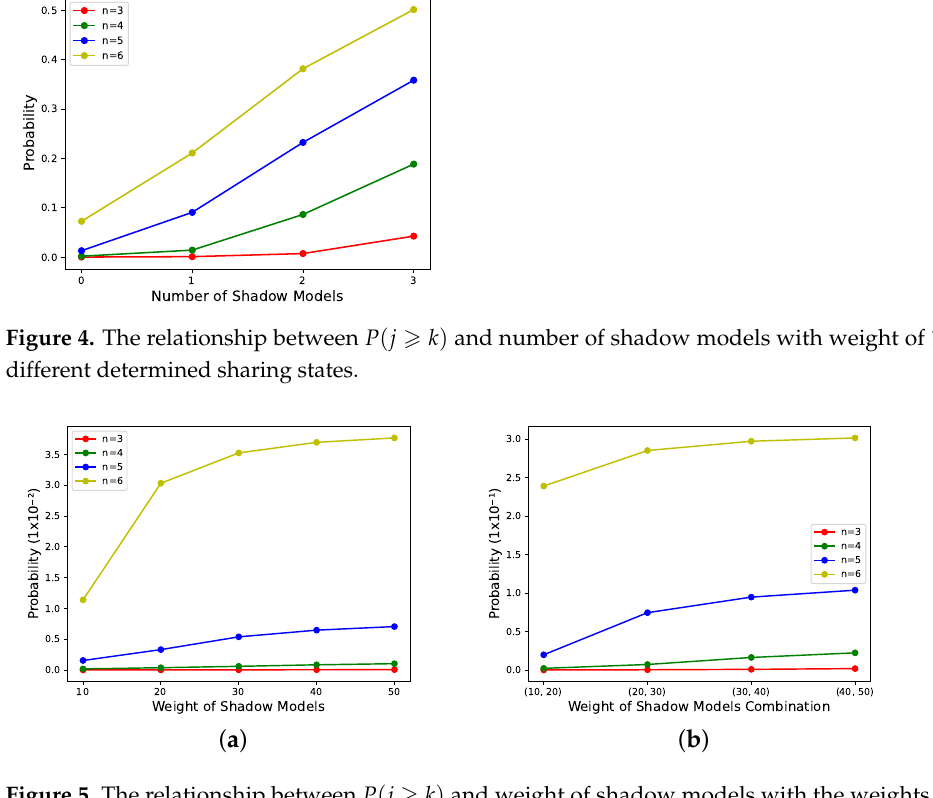
Figure 5. The relationship between P ( j (cid:62) k ) and weight of shadow models with the weights other than 1 for different determined sharing states. ( a ) The number of shadow models with weights other than 1 in set x is 1. ( b ) The number of shadow models with weights other than 1 in set x is